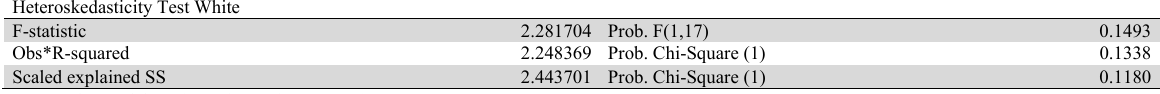
Heteroscedasticity test